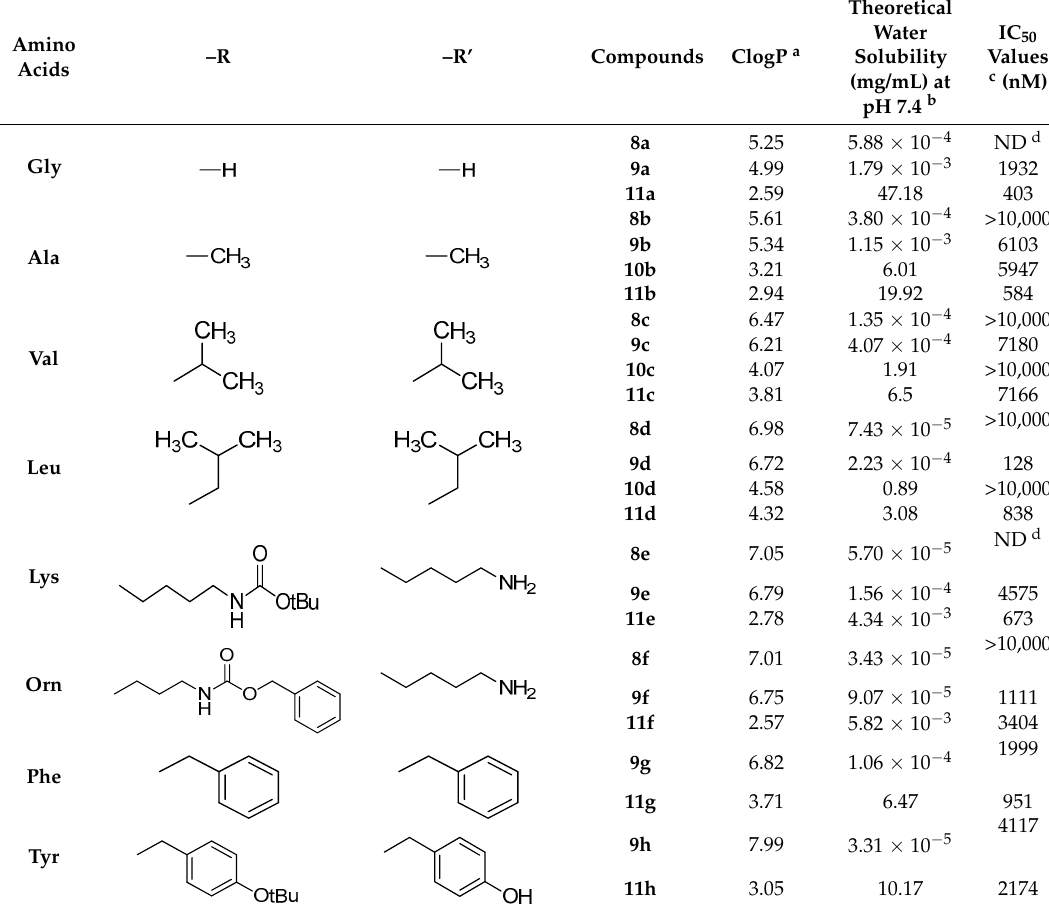
Table 1. Synthesis of imidazo[1,2- a ]quinoxaline derivatives grafted with the α -amine of the amino acid as described in Scheme 2: cLogP, theoretical water solubility (mg/mL) at pH 7.4 calculated values and IC 50 values against A375 (human melanoma cell line).